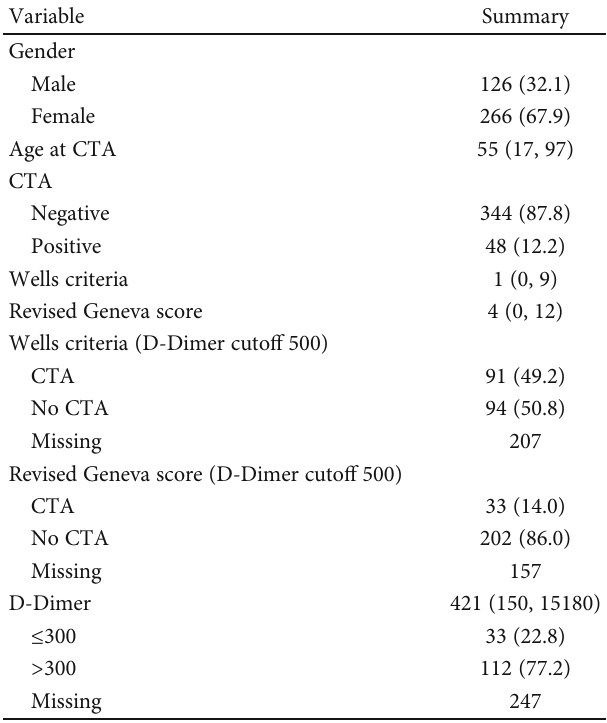
Table 4: Demographics, Wells criteria, revised Geneva score,